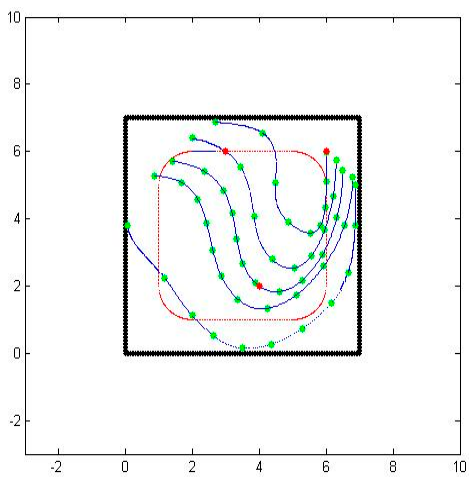
Figure 5. Primary air-borne particle paths going through three sensors and an additional sensor.